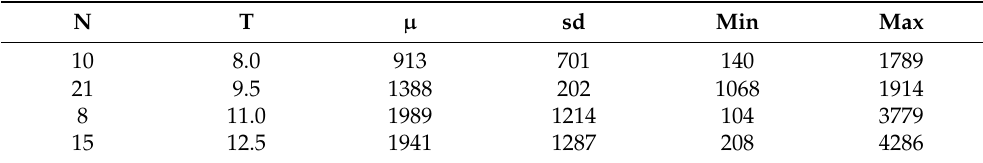
(Table S1) ranged from 0.0011 to 0.0016 mg (mean ± SD = 0.0014 ± 0.0001 mg). Mass- × h (Table 1). The average OCRs at the test temperatures are reported in Table 1. Table 1. Mean ( μ ), standard deviation (sd), minimum (Min), and maximum (Max) values of oxygen consumption rates (ng O 2 /mg DW × h) and number (N) of the female individuals of Moraria sp. used in this study at four assay temperatures (T; °C). N T μ sd Min Max